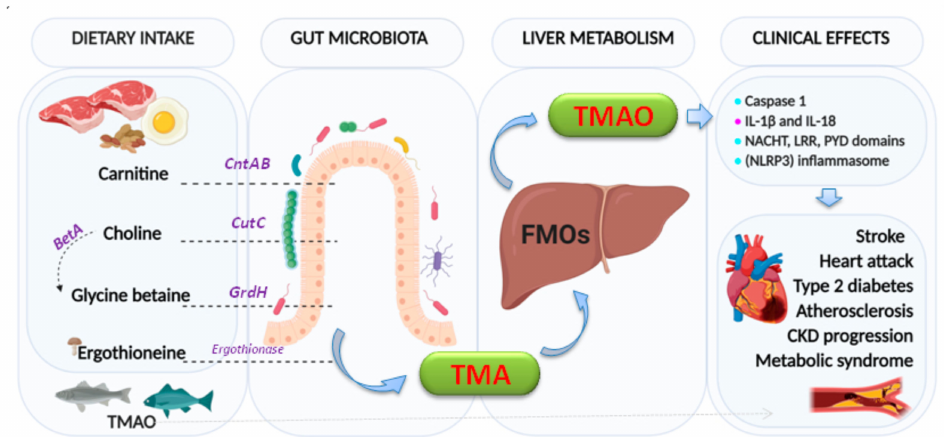
Figure 2. Formation of trimethylamine (TMA) and trimethylamine N-oxide reductase (TMAO). The key enzymes responsible indicated are: carnitine monooxygenase (CntAB); choline-TMA lyase (CutCD); glycine betaine reductase (GrdH) ; and Ergothionase. Choline to glycine betaine is mediated by the Bet pathway ( BetA ). FMOs: flavin-dependent monooxygenase (isoforms 1,3).